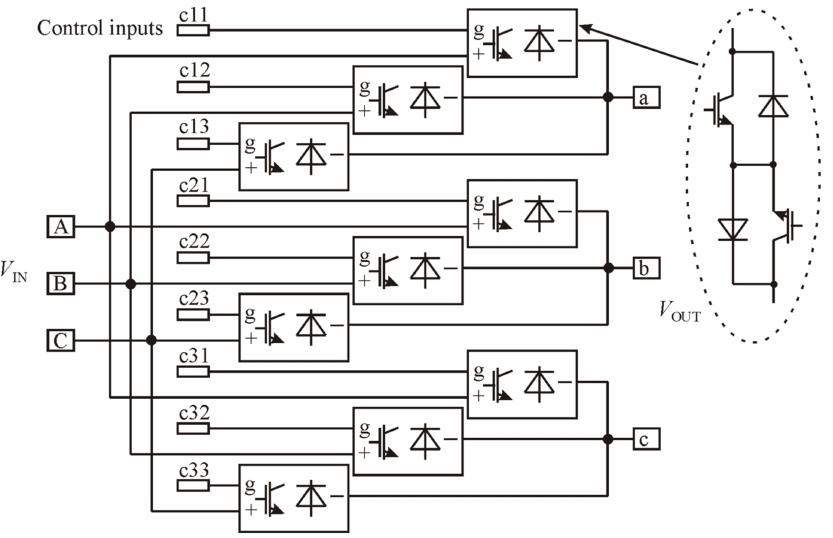
Figure 12. Structural diagram of the nine ideal bidirectional switches in Matlab/Simulink